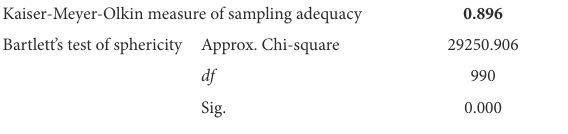
TABLE 1 Sample adequacy test.